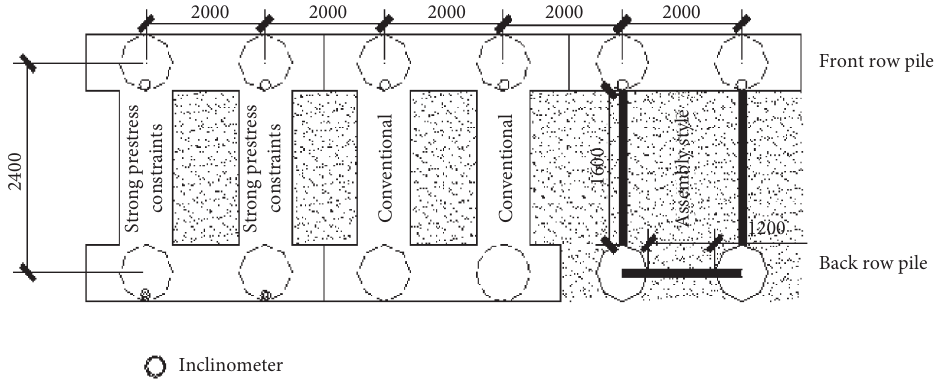
Figure 8: Inclinometer plan.